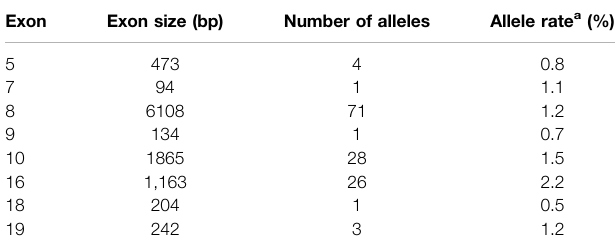
TABLE 4 | Allele rate and distribution of ALMS1 variants in different exonsfrom 69 Chinese ALMS families. Exon Exon size (bp) Number of alleles Allele rate a